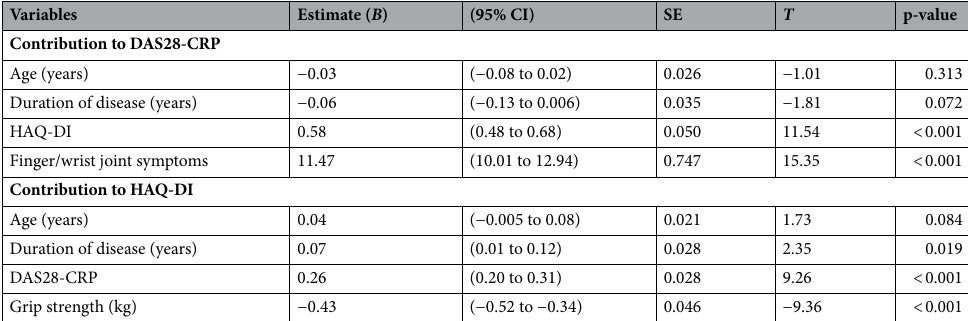
Table 2. Linear regression analysis of DAS28-CRP and HAQ-DI. P < 0.05 was considered statistically significant. DAS28-CRP 28-joint count Disease Activity Score using C-reactive protein, HAQ-DI Health